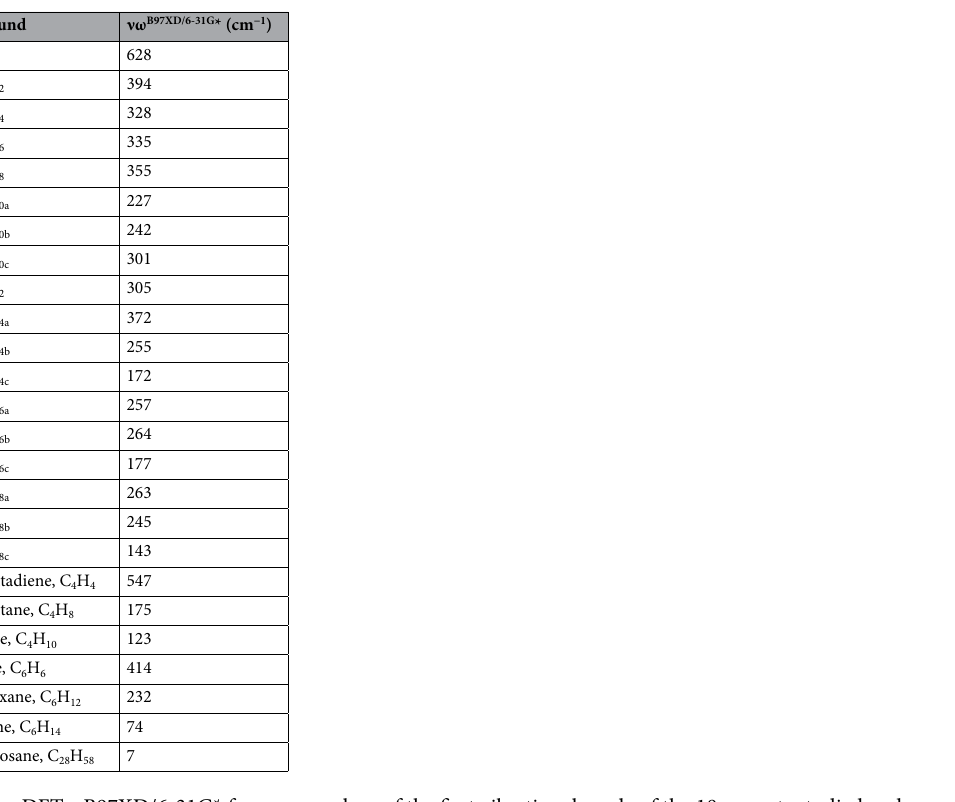
Table 3. DFT ωB97XD/6-31G* frequency values of the first vibrational mode of the 18 nuggets studied and a few other compounds for comparison purposes.